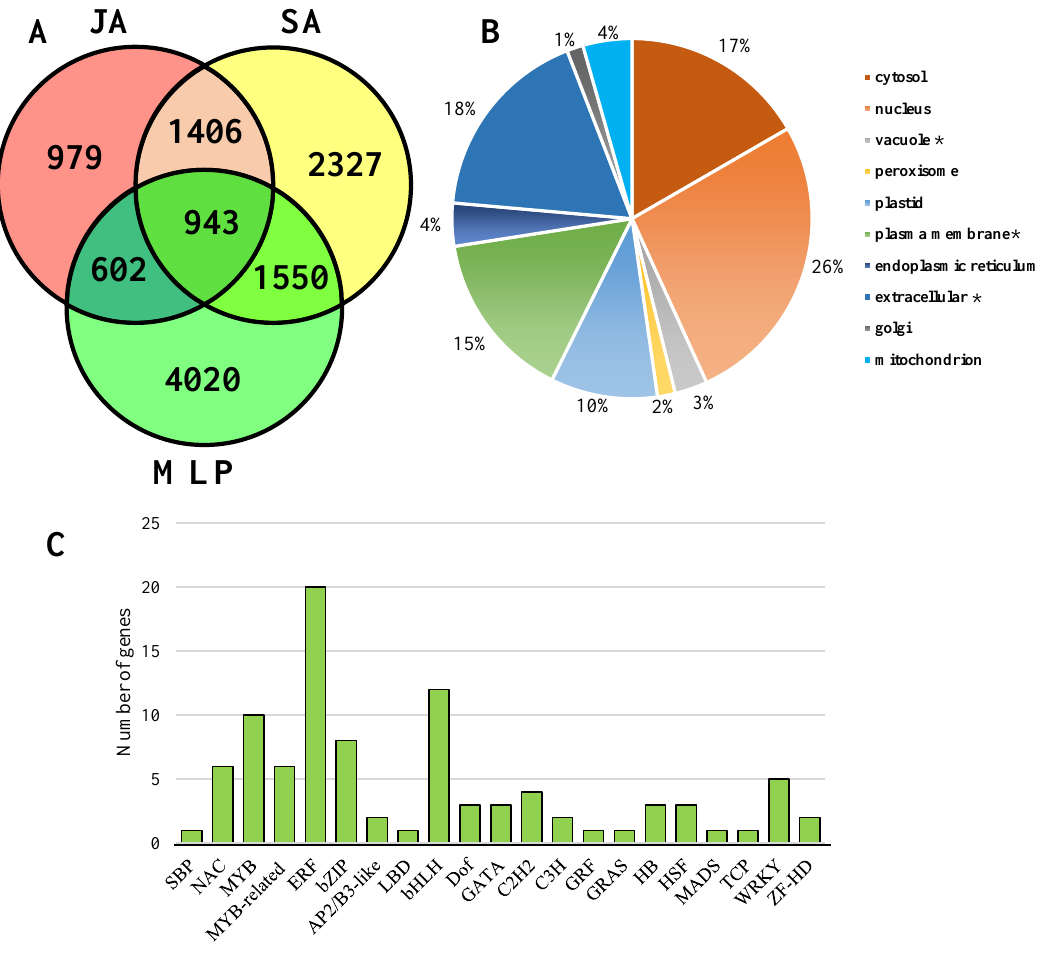
Figure 1. Venn diagram represented the number of specific and overlapping genes identified as jasmonic acid (JA)-responsive, salicylic acid (SA)-responsive, and Melampsora larici-populina (MLP)-responsive genes ( A ). The proportion of cellular locations of proteins encoded by common responsive genes (CRG, ( B )). The star behind the cellular location indicates that the p -value of the hypergeometric distribution test was less than 0.05. The gene numbers in each transcription factor family were showed in CRG (C).